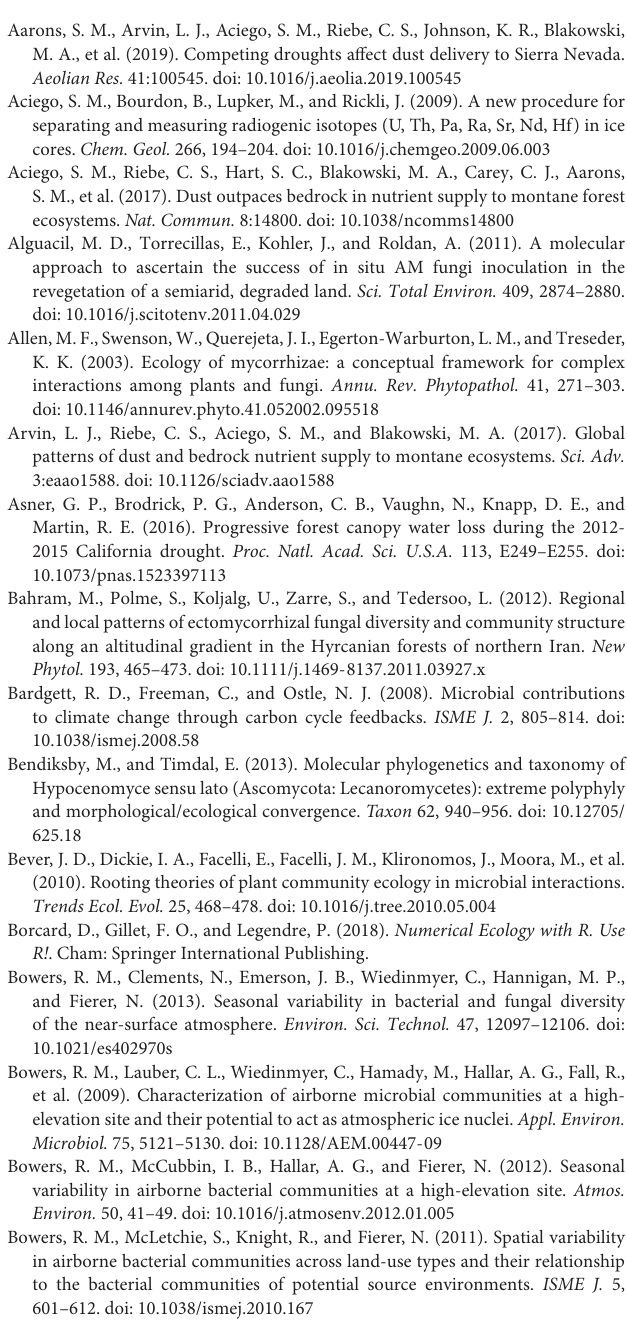
(IGSN) is an alphanumeric code that uniquely identifies samples taken from the environment. Supplementary Table 2 | Fungal taxa representing fungal tropic modes. Fungal taxa associated with each functional group, as assigned through FUNguild (as per Nguyen et al.,